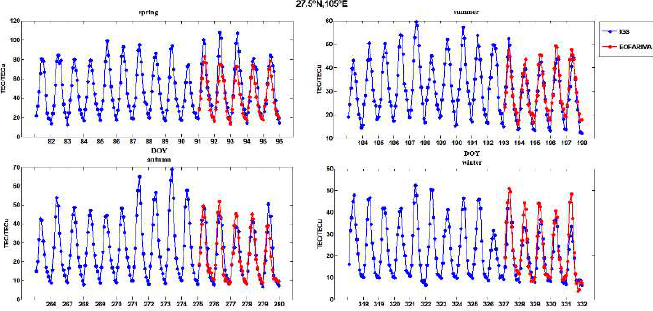
Figure 5 (27.5°N,105°E) VTEC value of grid node In order to deeply analyze the prediction effect of EOF-ARIMA model in Guangxi region, the prediction accuracy of two models representing 6 character nodes Table 1 VTEC prediction accuracy statistics of the two models in 4 representative character nodes in Guangxi region